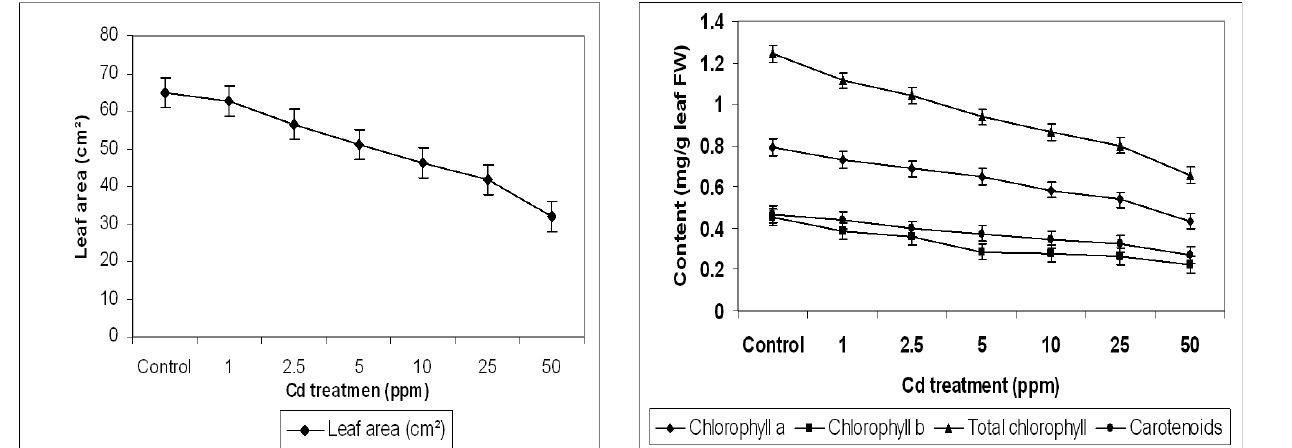
Fig. 1. Effect of various concentrations of Cd (as CdCl average of leaf area (cm²) of radish plants grown in sand culture at the harvest time (40 days) Tab. 1. Cd accumulation and micronutrient contents in leaves and roots of radish plants at harvest time (40 days of growth)